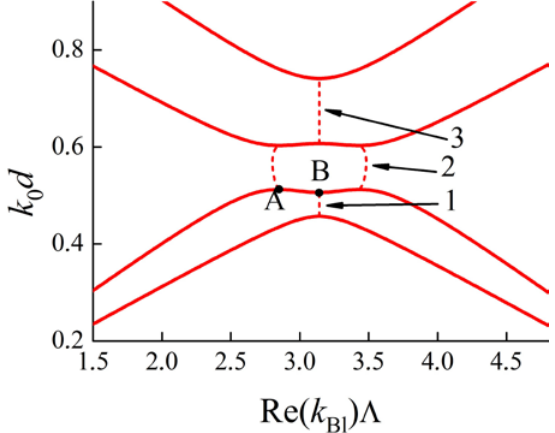
Figure 7. Frequency dependence k Λ for a multilayer PC ( d —thicknesses k d on ( ) Re Bl 0 of all layers, 2 d Λ = is a PC period). The solid lines correspond to propagating waves, the dashed lines correspond to BGs. 1 and 3 are Brillouin BGs, 2 is a DBG. А is a DBG boundary, B is a Brillouin BG